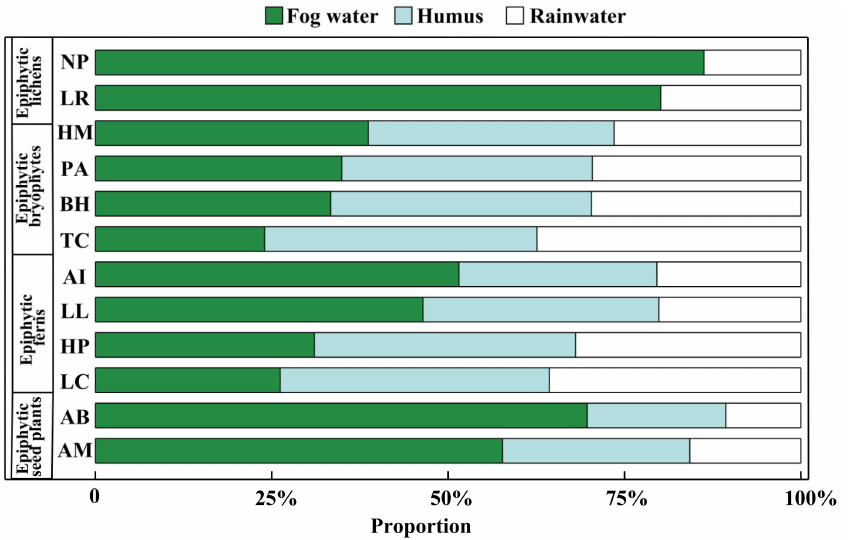
Figure 5. Partitioning of potential water sources of epiphytes from different groups by MixSIAR model in a subtropical montane cloud forest in the dry season. The abbreviations of species names are the same as in Figure 4.